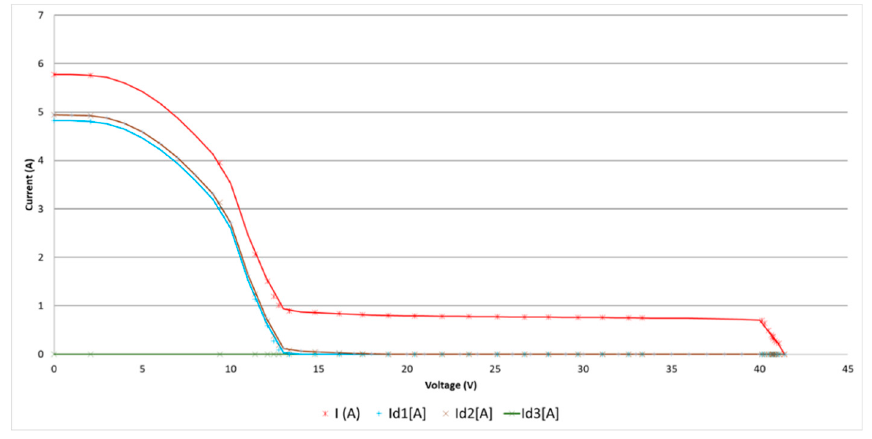
Figure 6. Experimental monocrystalline solar module I–V characteristic curve in condition 3.